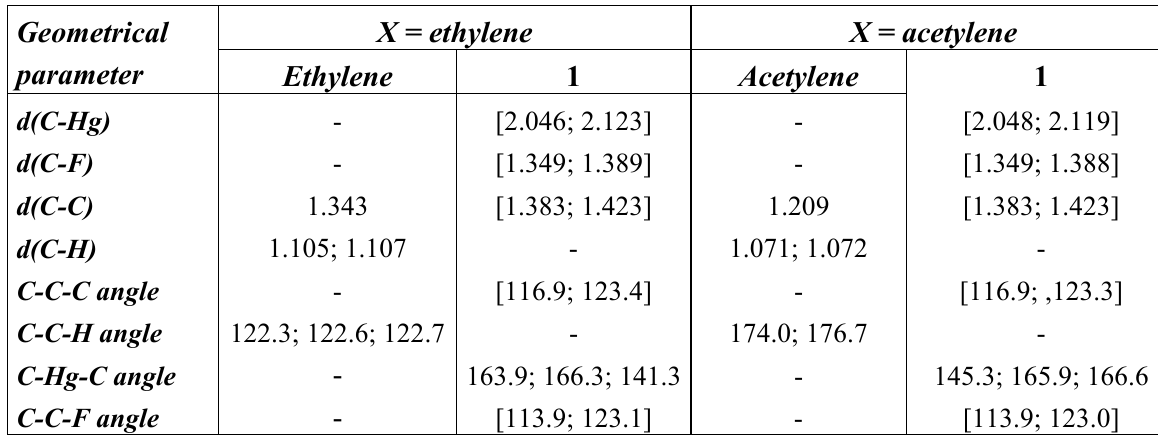
Table 2. Significant structural data for 1 · X